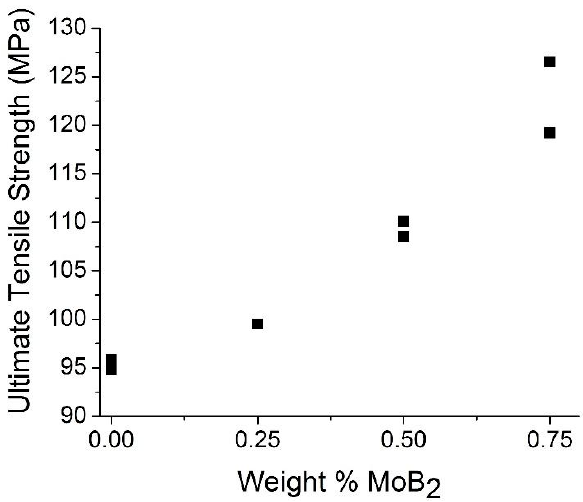
Figure 10. Measured ultimate tensile strength (UTS) as a function of the amount of MoB 2 in the wires.